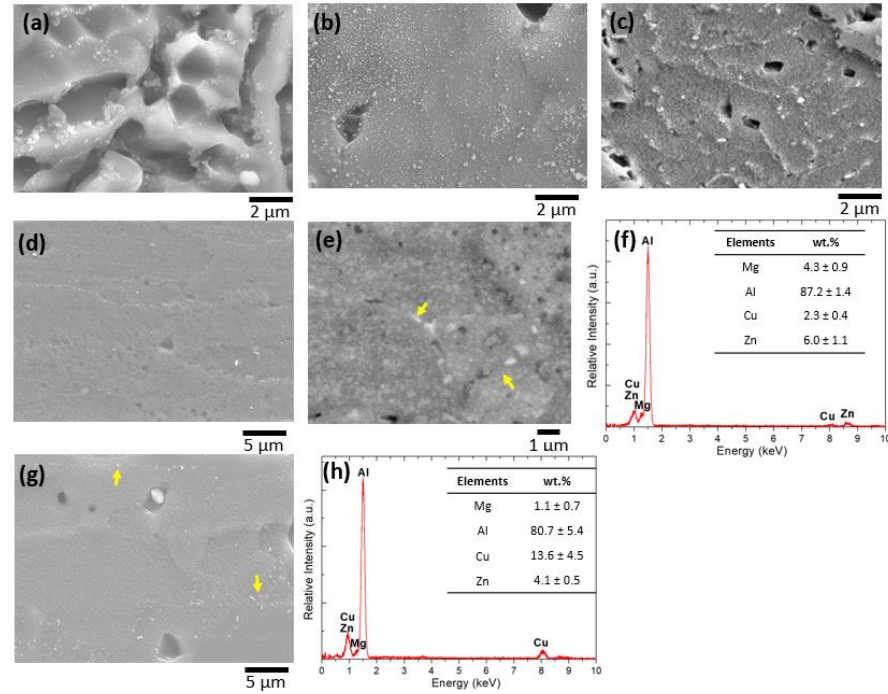
Figure 18. ( a – c ) SEM images of the WM in standard, water-quenched and air-quenched samples, respectively, ( d , e ) BSE images, and ( f ) EDS analysis of precipitates detected in the BM of air-quenched, and ( g ) BSE images and ( h ) EDS analysis of precipitates detected in the BM water-quenched samples.